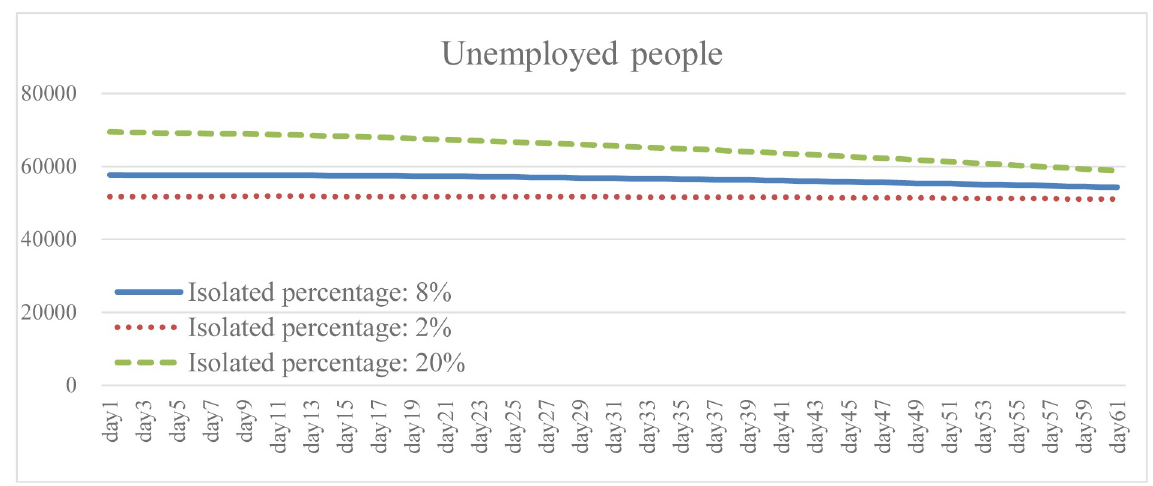
Fig 8. Unemployed people under different isolation percentage.